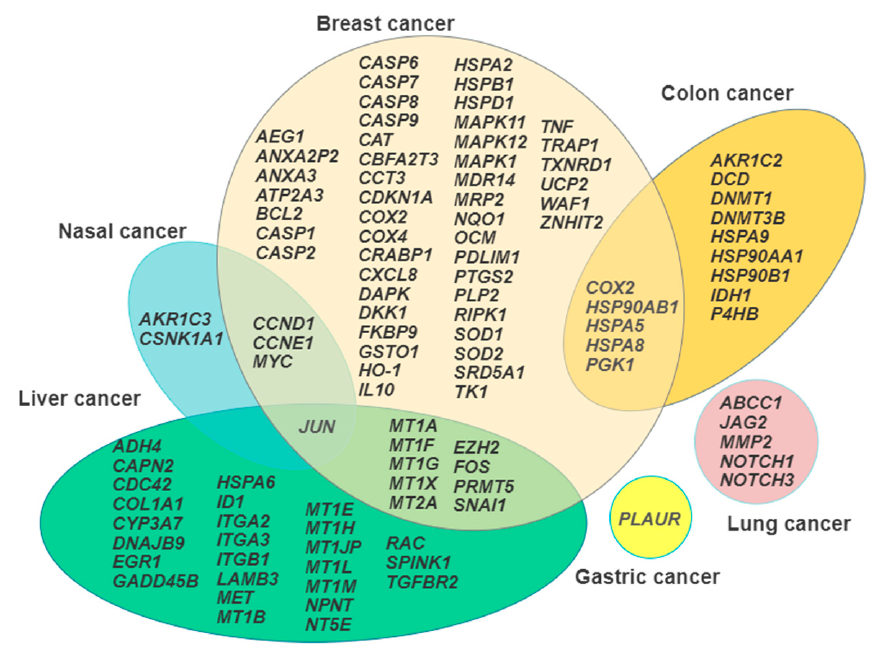
Figure 1. Venn diagram illustrating the gene signature arrays in each cancer cell model examined and the overlapping areas among the model systems.